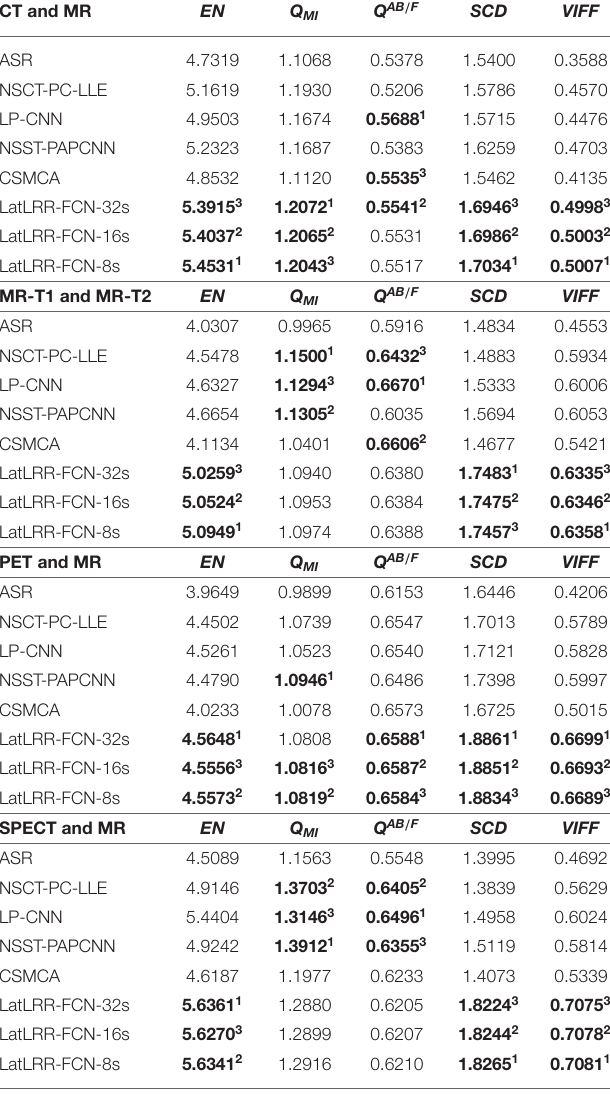
TABLE 2 | Five metrics of different methods for the four medical image fusion problems (a higher value for each metric indicates a better performance). CT and MR